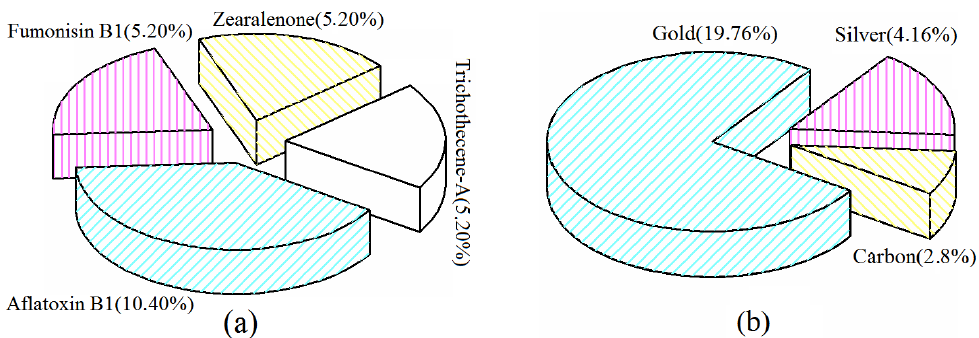
Figure 2. Percentage of studies which ( a ) addressed the different types of mycotoxins (Blue: Aflatoxin B1; Purple: Fumonisin B1; Yellow: Zearalenone; White: Trichothecene–A); and ( b ) the nanomaterials used in the ICST design (Blue: Gold; Purple: Silver; Yellow: Carbon).